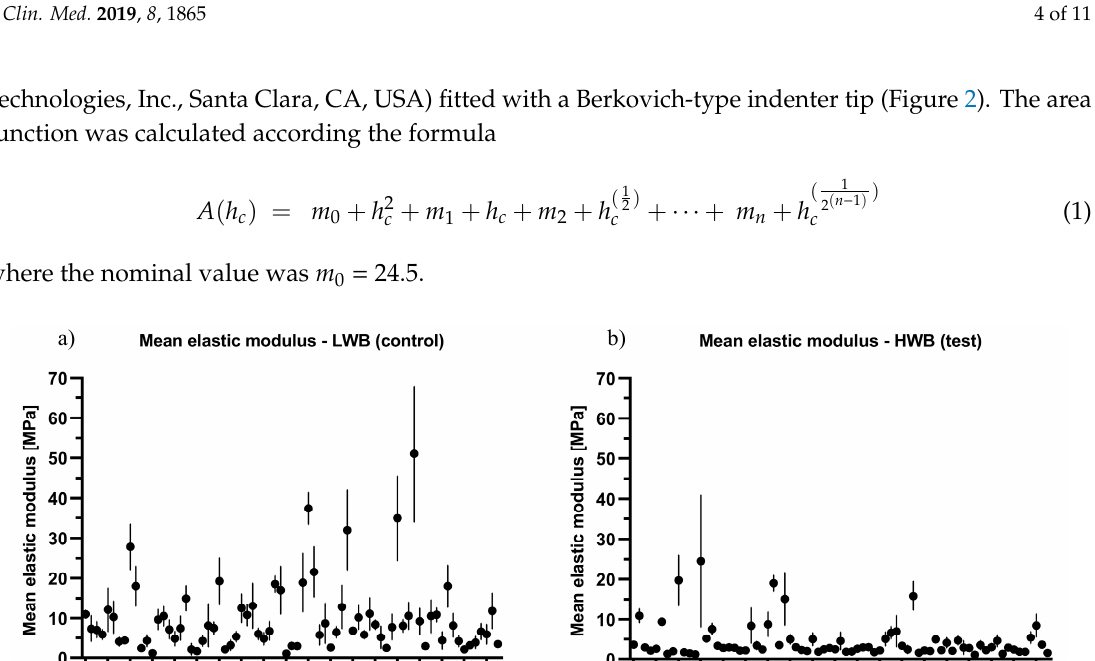
Figure 3. Scatter plot of hardness against age: ( a ) low weight bearing (LWB) sample and ( b ) high weight bearing (HWB) sample.